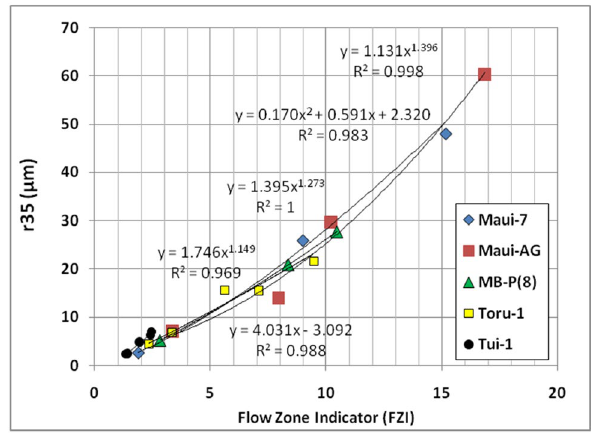
Fig. 9 Plotting of RQI versus Normalized Porosity Index showing hydraulic flow units